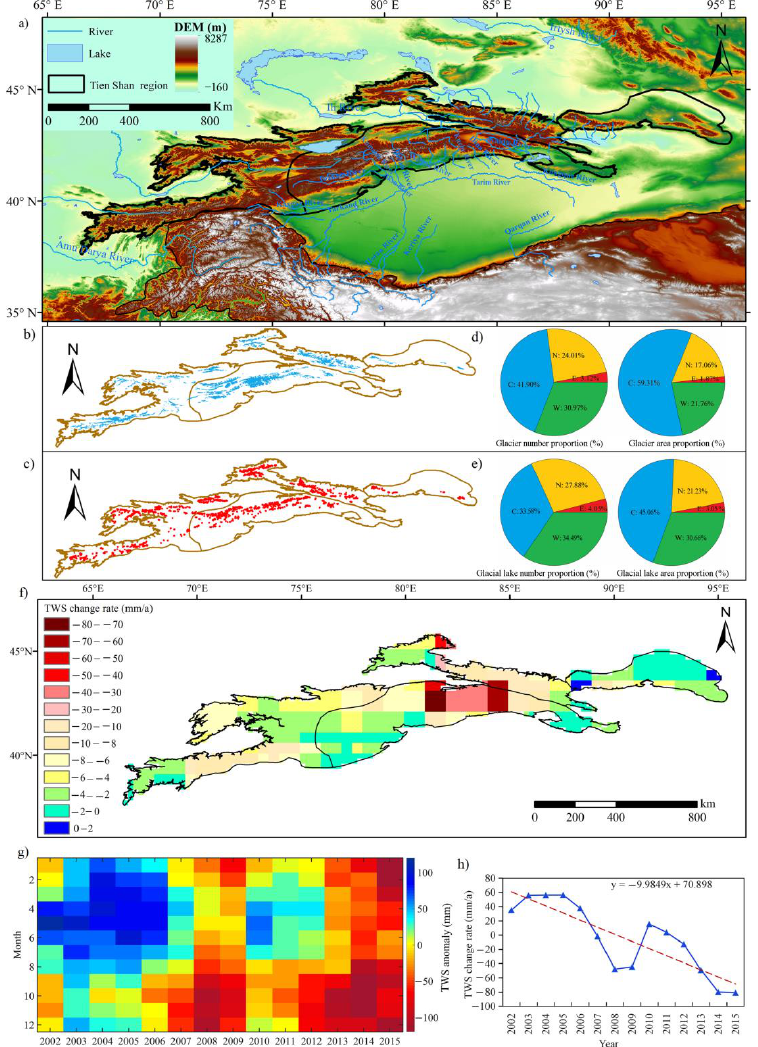
Figure 10. Geographical information in the TS region ( a ); spatial distribution of glaciers and glacial lakes ( b , c ); the proportion of glaciers and glacial lakes ( d , e ); spatial variations in annual TWS ( f ); variations in monthly TWS ( g ); variations in annual TWS ( h ).